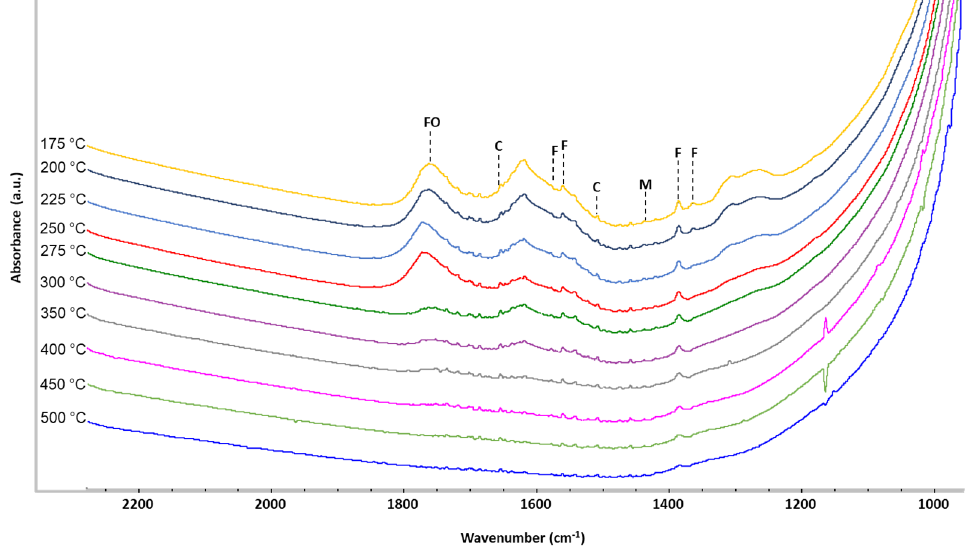
Figure 10. Operando FTIR spectra for CO 2 methanation over the Ni/Ti catalyst. Species identification: HC (hydrogen carbonate), MC (monodentate carbonate), BC (bidentate carbonate), PC (polydentate carbonate), F (formate), M (methoxy), FO (formaldehyde), and C (carboxylate).